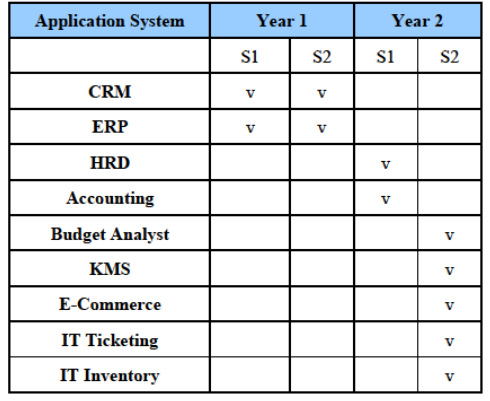
Figure 17: IS Development Road